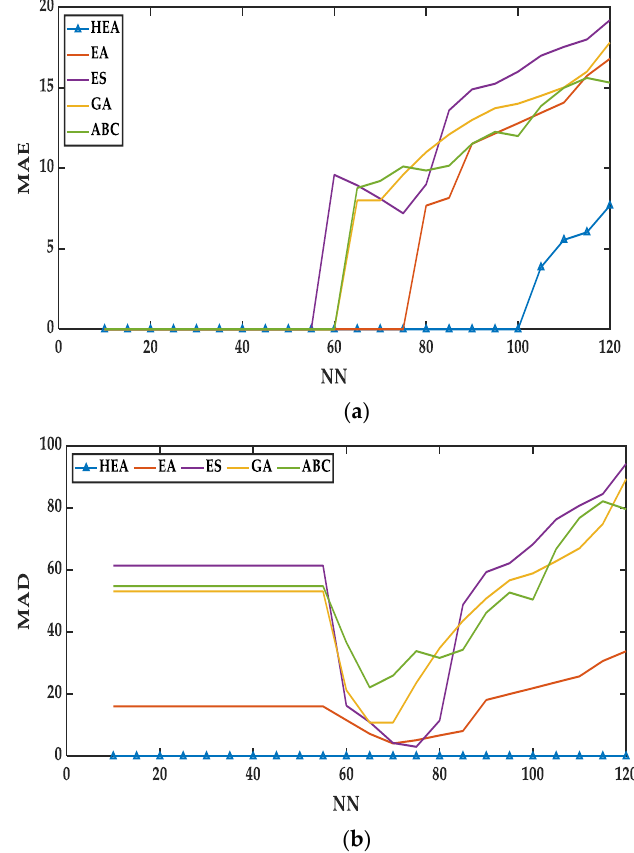
Figure 6. ( a ) MAE-Diversity of different RAN k SAT models. ( b ) MAD-Diversity of different Figure 6. ( a ) MAE -Diversity of different RAN k SAT models. ( b ) MAD -Diversity of different RAN k - RAN k SAT models. SAT models. Table 6. Tabulated MAE-Diversity values for different DHNN-RAN k SAT models. Table 6. Tabulated MAE -Diversity values for different DHNN-RAN k SAT